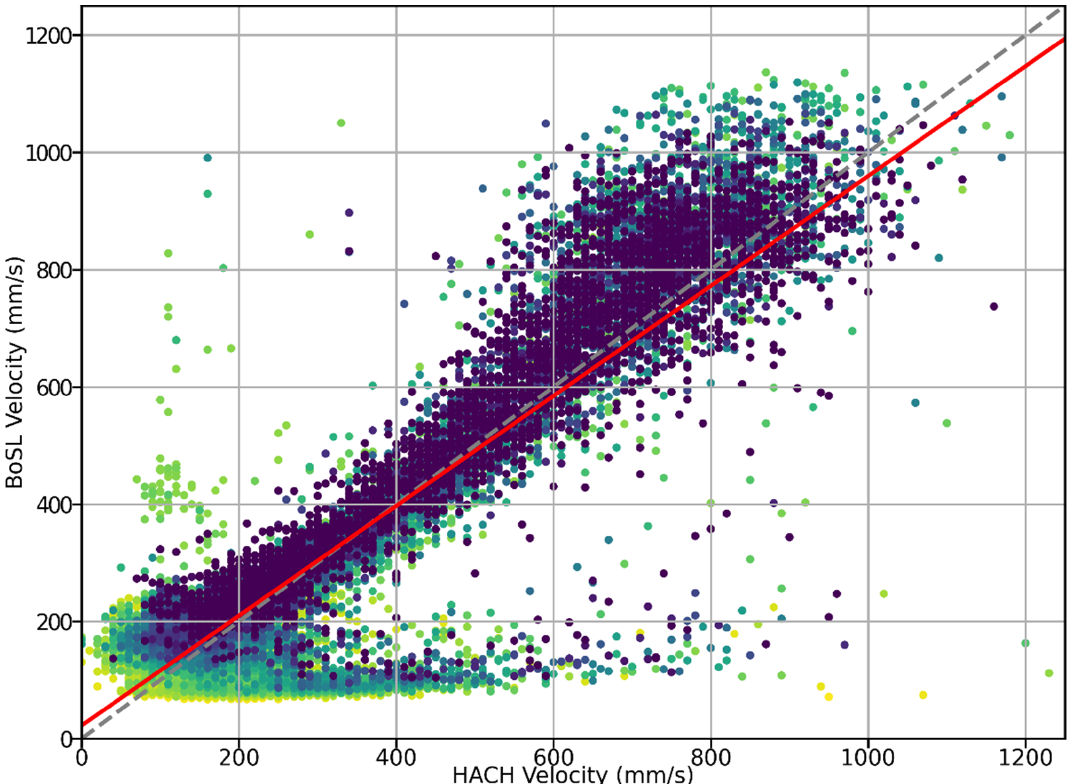
Figure 8. Plot of the sensor measured velocity on the y-axis vs. HACH probe measured velocity on the x-axis. Points are coloured according to signal strength, with darker points having a higher signal strength. Red: line of best fit with gradient 0.94 and y-intercept 22 mm/s, R 2 value 0.78, probability of null hypothesis of gradient equal to zero p < 0.0001. Linear regression calculated using SciPy [33]. Grey dashed line: 1:1 correlation. A few data points are beyond the plot range; the full data extends to 3000 mm/s on the x axis.